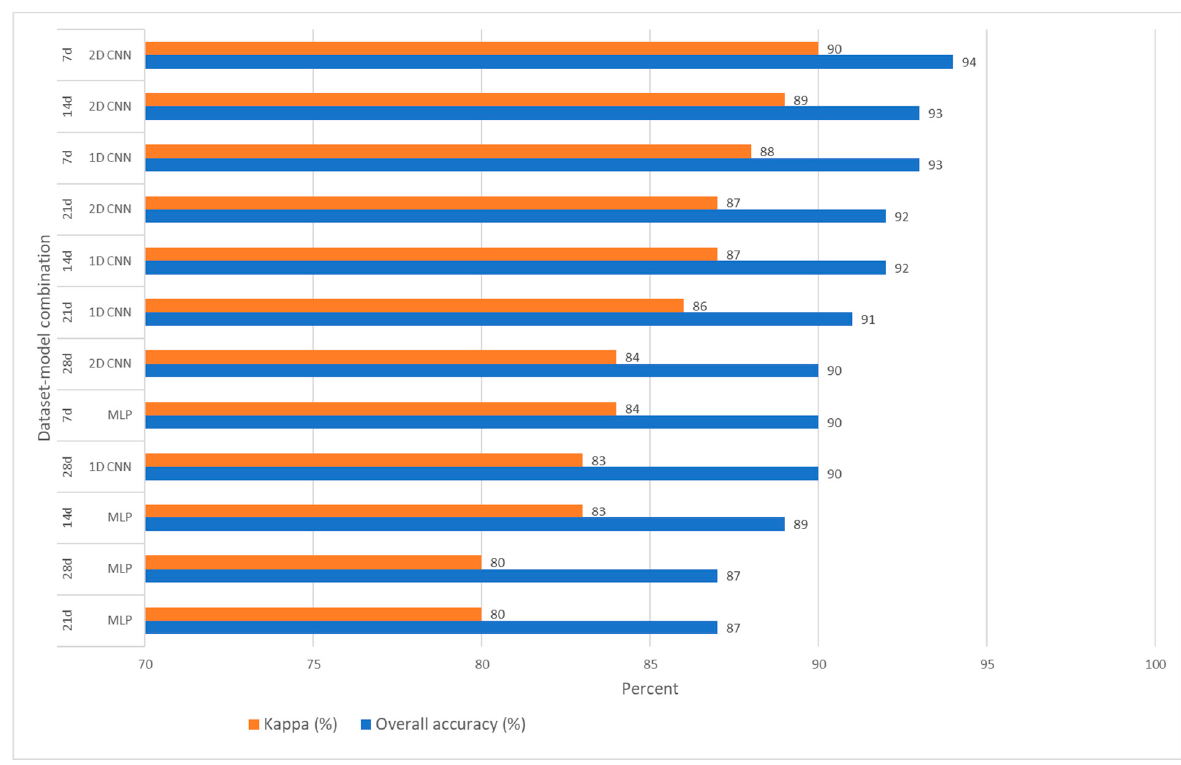
Figure 4. Test of overall accuracies and Cohen’s Kapa of the twelve model–dataset combinations, as obtained based on the test